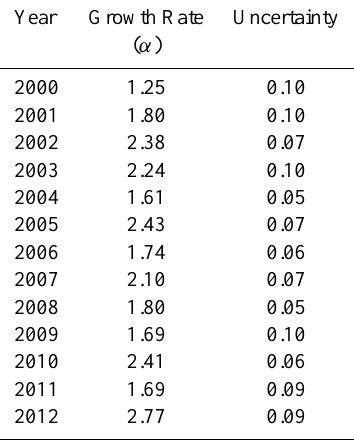
Table 1. Mean annual CO 2 growth rates published on the ESRL- NOAA webpage: http://www.esrl.noaa.gov/gmd/ccgg/trends/ global.html. The rates and their uncertainties are expressed in ppmyr − 1 .